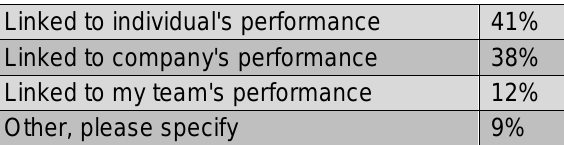
Table 6. Preferences Regarding Allocation of ESO Linked to individual's